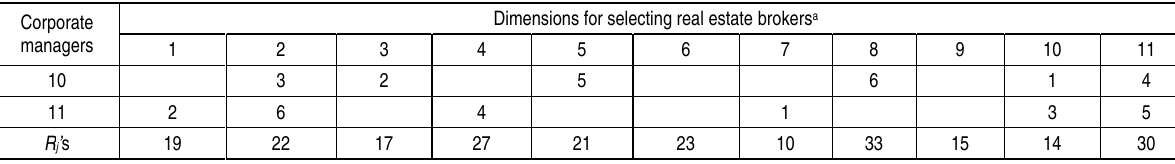
Table 1 (cont.). Ranking of dimensions for selecting real estate brokers